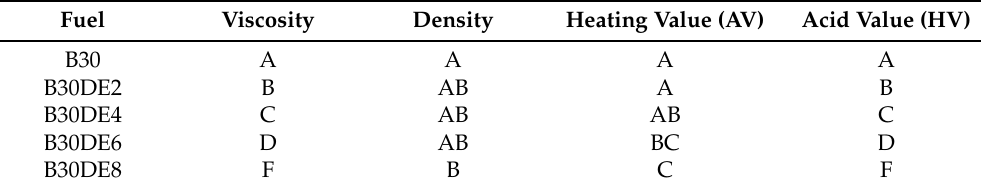
Table 3. Tukey grouping results for the fuel properties.